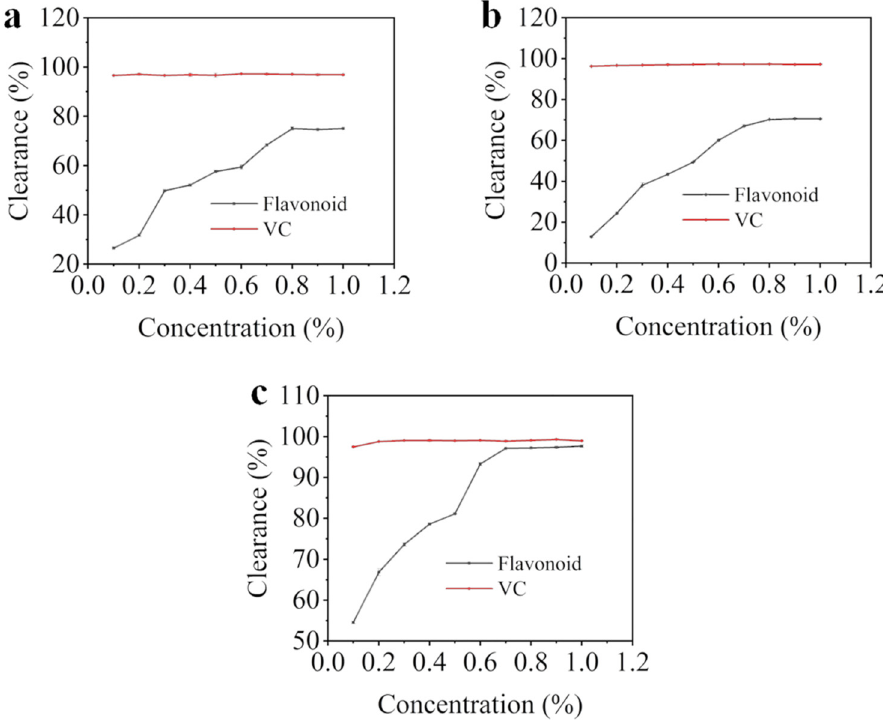
Figure 3. The clearance of total flavonoids to DPPH free radical ( a ), hydroxyl radical ( b ) and ABTS free radical ( c